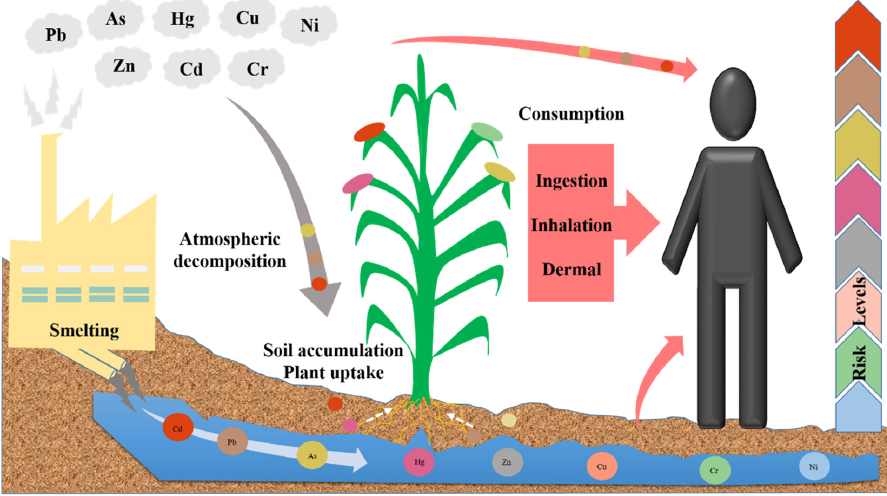
Figure 2. Release of heavy metals and their dominant exposure and possible uptake routes to hu-